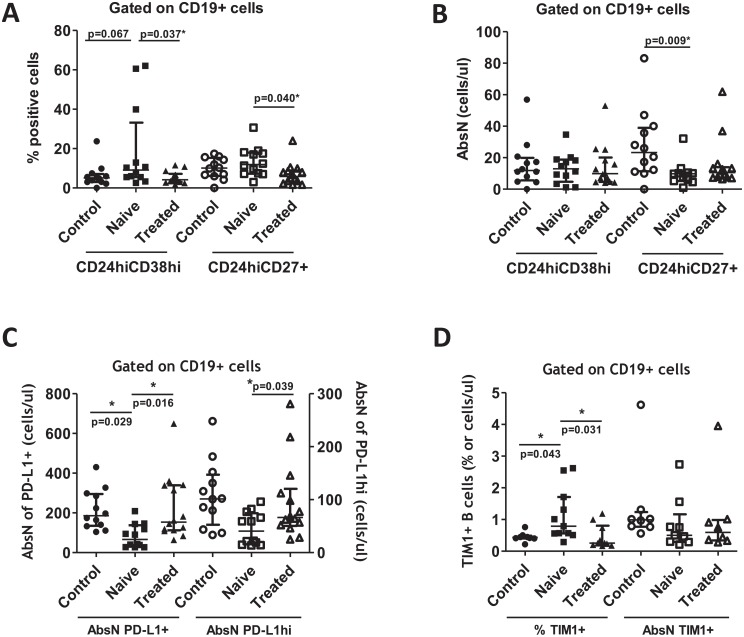
Breg compartments in HIV+ and healthy individuals.(A) Frequencies and (B) absolute numbers (AbsN) of CD24hiCD38hi and CD24hiCD27+ Breg subsets. (C) Absolute numbers of PD-L1+ and PD-L1hi B cells. (D) Frequencies and absolute numbers of TIM-1+ B cells. All of these subsets were determined in whole blood using cell surface labeling. Frequencies of Breg were obtained relative to CD19+ cells. Medians ± IQRs are represented. Control: Healthy individuals. Naïve: HIV+ treatment-naïve individuals. Treated: Treated-HIV+ individuals. * = p<0.05 when comparing conditions. Each symbol corresponds to an individual.